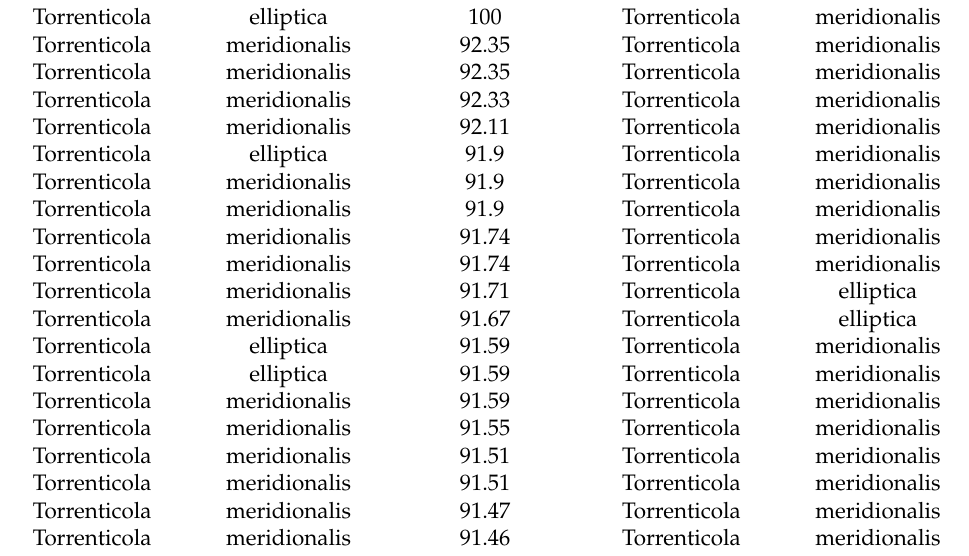
Table 2. BOLD System results obtained using, as the input, a COI sequence of T. elliptica (OL870191.1; left column) versus one of T. meridionalis (OL870276.1; right column). Percent similarity is also